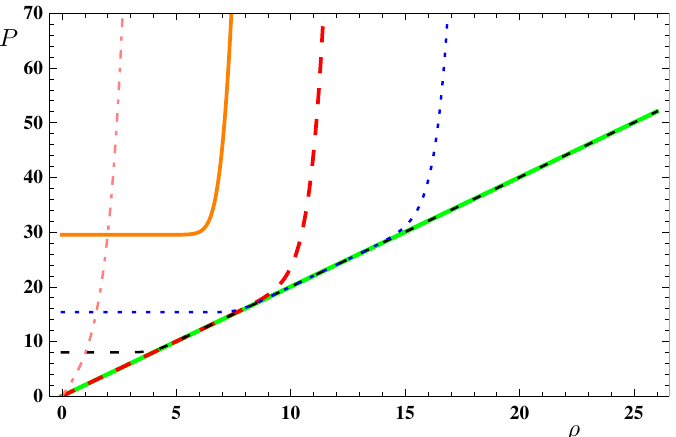
Figure 1 . Six examples of solutions to the master equation representative of all the classes discussed in section 2. In green the function P = 2 (cid:26) , the CVMN solution. In black (short dashing) a solution that has the CVMN behavior for (cid:26) > (cid:26) (cid:3) a solution that has the CVMN behavior for (cid:26) < (cid:22) (cid:26) blue (dotted) a solution that has P and then behaves as P